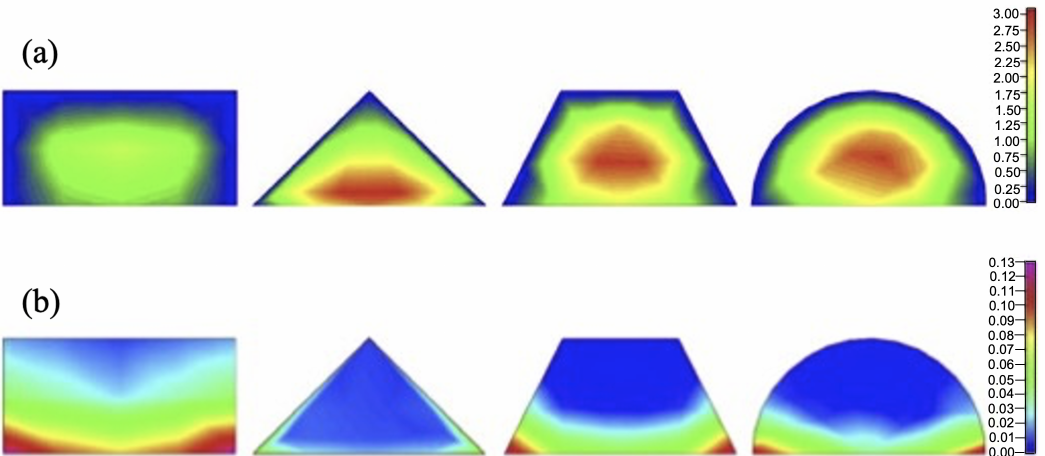
Figure 3. The distribution of ( a ) liquid water saturation and ( b ) flow velocity (m/s) in a channel for various cross-section shapes [47].